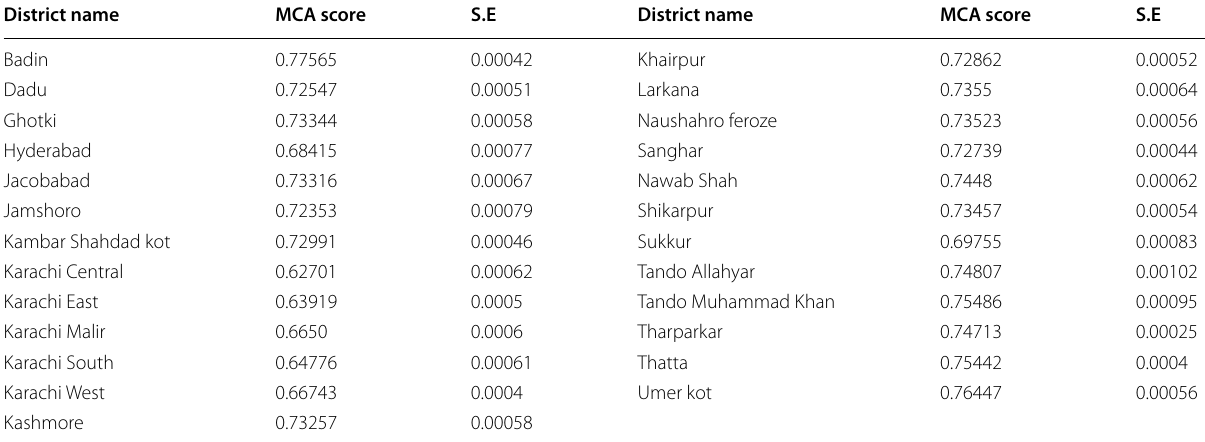
Table 6 Asset-based poverty index for districts of Sindh province. Source: Author’s own calculation District